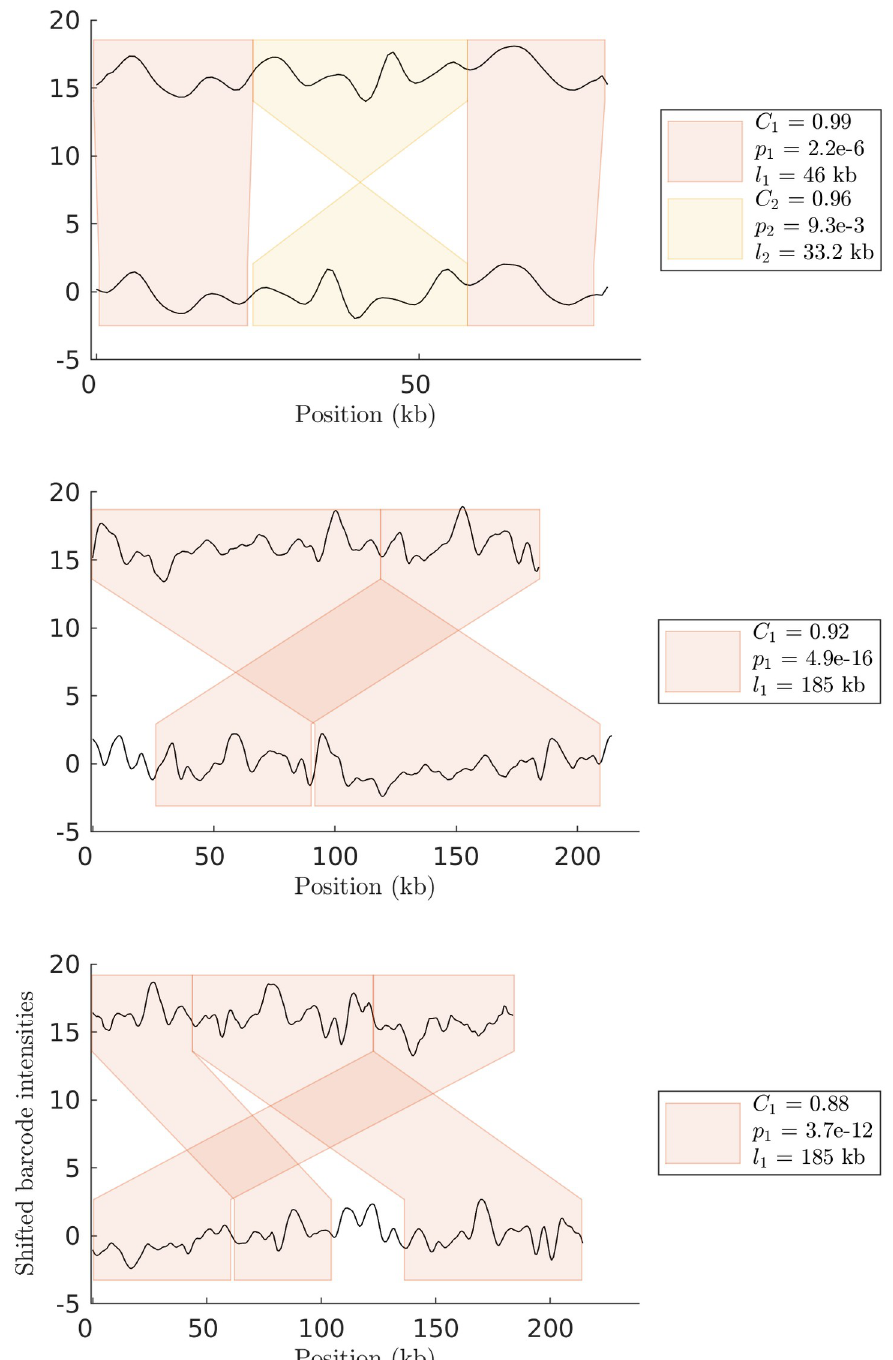
Fig 5. HMM output for real data from a neonatal outbreak. (Top) Output of the HMM method for comparison of two experimental ESBL-KP 80 kb consensus barcodes. Detected sub-barcode pairs suggest that there was a roughly 33 kb inversion in the middle. (Middle) Output of the HMM method for comparison of two experimental 215 kb consensus barcodes from different patients taken at approximately the same time. We find that all smaller sub- barcodes have been merged together, and there is a deletion (30 kb) on the reference barcode. (Bottom) Output of the HMM method for comparison of two experimental 215 kb consensus barcodes which shows a change that occurred within a patient over a 2 years period. Same color boxes contain significantly matching sub-barcodes. The detected sub-barcode has a dist score C i , p-value p i , and is of length l i .